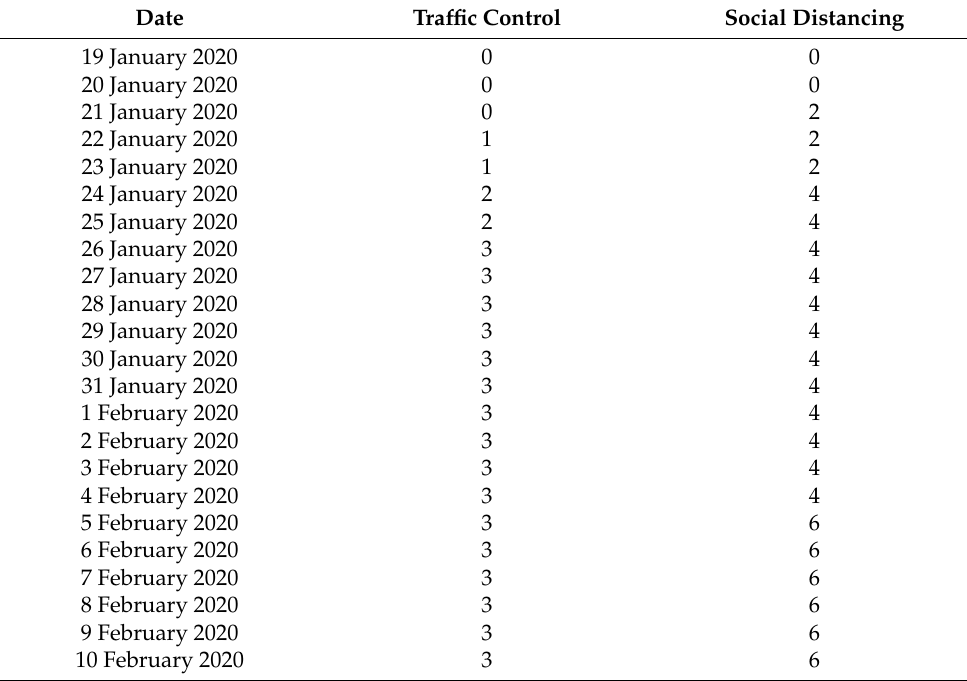
Table 2. Traffic control and social distancing score of shanghai.